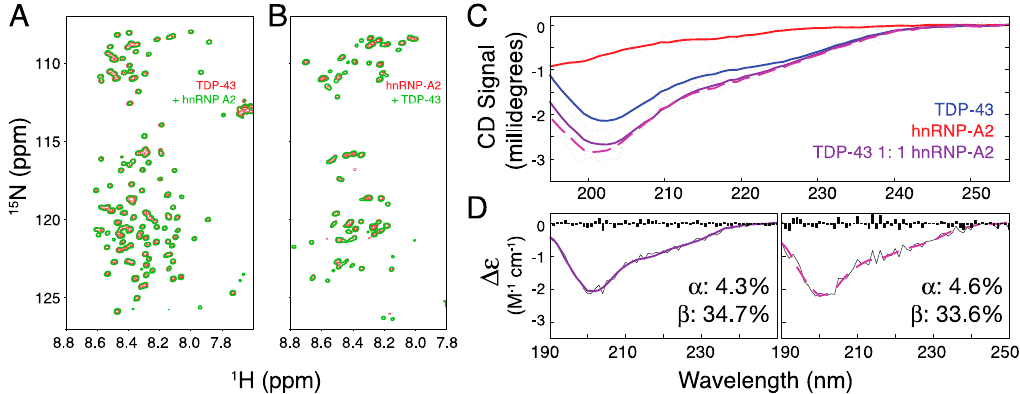
Figure 2. The interaction between the intrinsically disordered regions (IDRs) of TDP-43 and hnRNP-A2. ( A ) Overlaid NMR HSQC spectra of 20 µ M 15 N TDP-43 266–414 alone (red) and in the presence of 20 µ M 14 N-hnRNP-A2 288–341 (green). ( B ) Overlaid NMR HSQC spectra of 20 µ M 15 N- hnRNP-A2 288–341 alone (red) and in the presence of 20 µ M 14 N-TDP-43 266–414 (green). ( C ) Circular dichroism spectra of 20 µ M TDP-43 266–414 (blue), hnRNP-A2 288–341 (red), and a one-to-one mixture of the two (purple) overlaid on the summed spectra of the two proteins alone (broken purple line). ( D ) Fits using BeStSel [41,42] of the mixture (left panel) and numerically summed TDP-43 / hnRNP-A2 spectra (right) and the proportion of secondary structure components obtained. The residuals of the fits are shown as black bars.